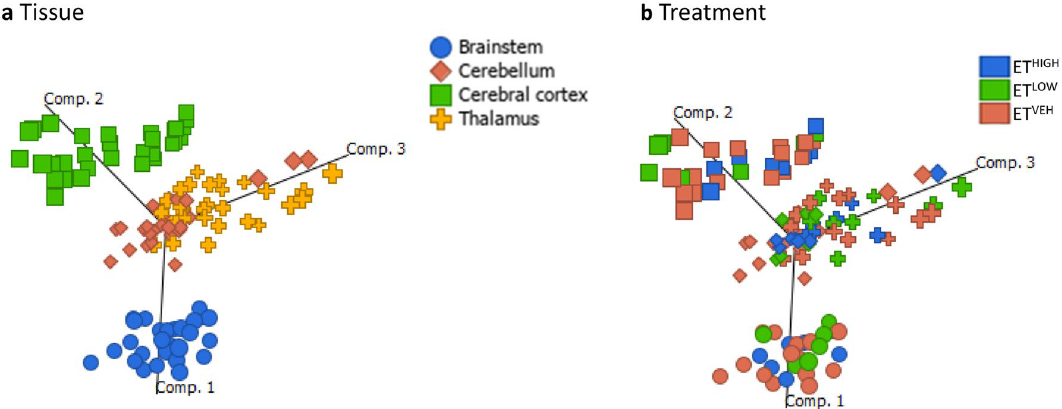
Figure 2. PCA scores plots of ESI + UHPLC-HRMS data coloured by ( a ) brain tissues: brainstem, cerebellum, cerebral cortex and thalamus and ( b ) treatments: ET HIGH (blue; 0.05 mg/kg; n = 8), ET LOW (green; 0.025 mg/kg; n = 6) and ET VEH (orange; 1% lactic acid; n = 8).